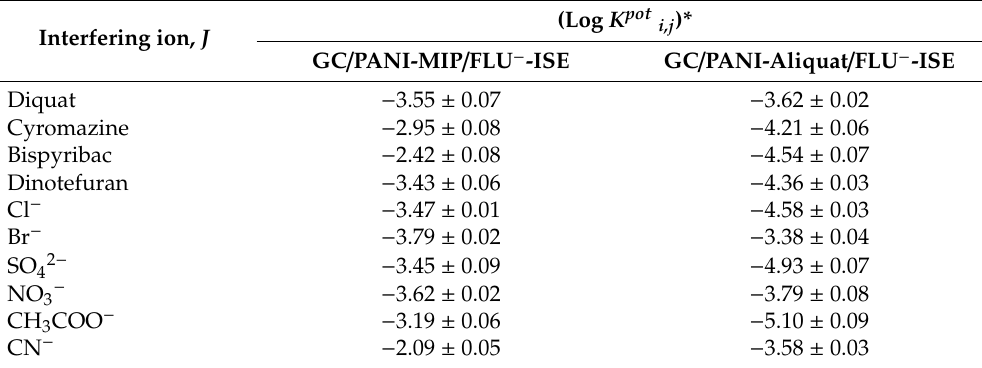
Table 2. Selectivity coe ffi cient values for the proposed flucarbazone